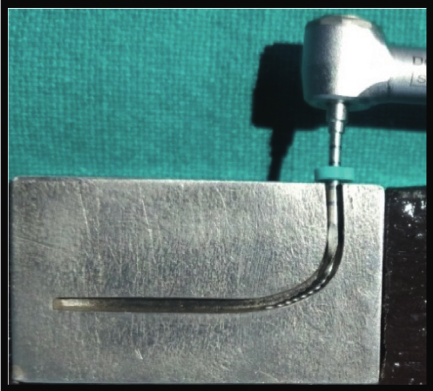
Figure 2: Rotary files instrumented in the simulated curved canals until